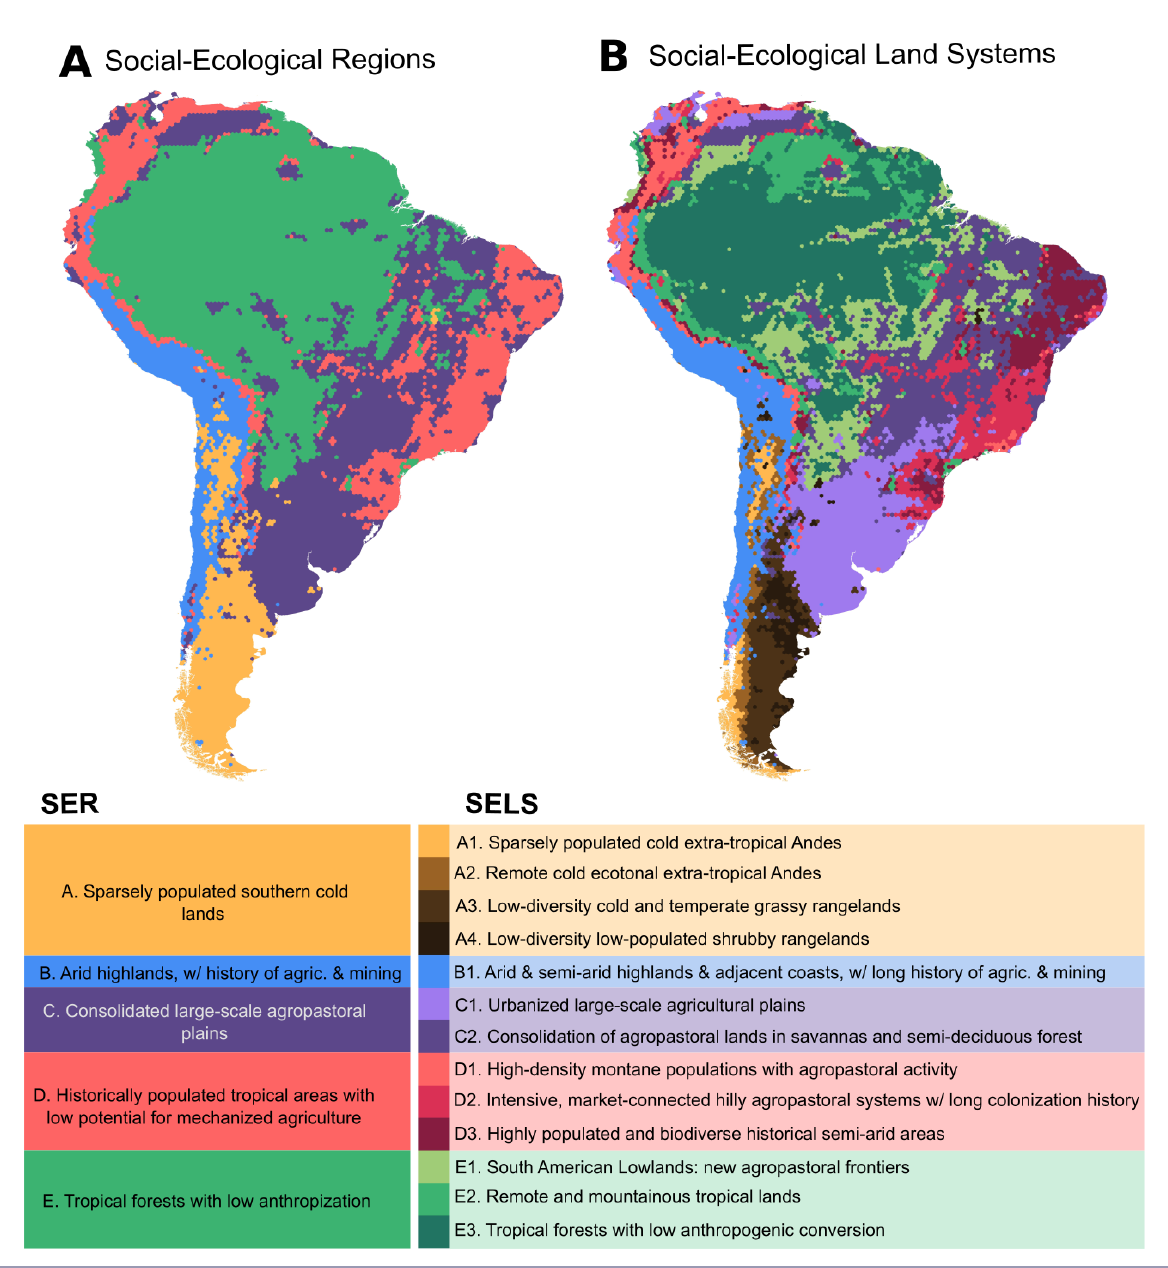
Fig. 1 . (A) Maps of social-ecological regions (SER) and (B) social-ecological land systems (SELS) of South America. The map depicts the spatial distribution of the typologies of social-ecological land systems in South America. High resolution map is available in Appendix